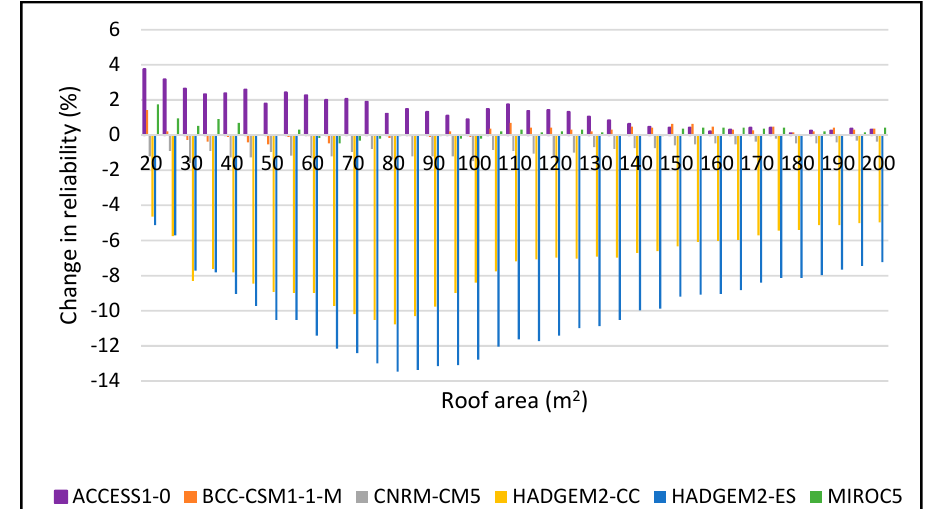
Figure 8. Change in reliability for DJF 2025–2055 period for 2 m 3 .